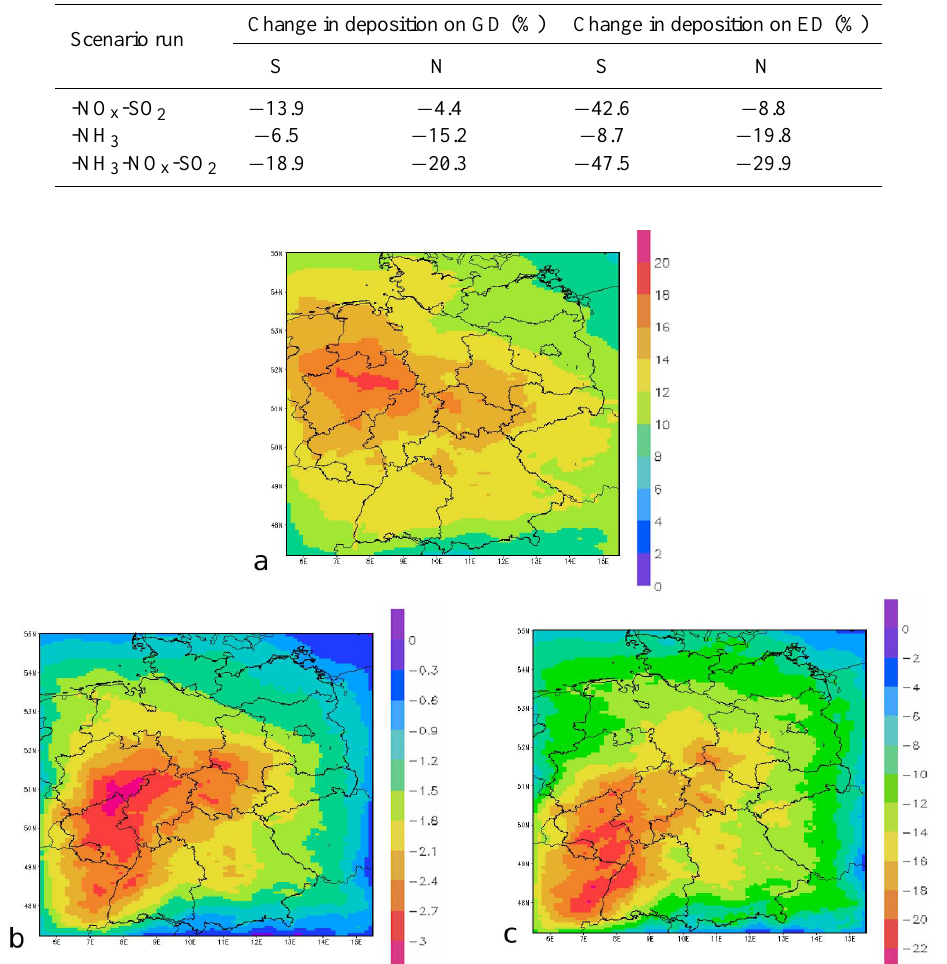
Table 6. Relative change in deposition of S and N compared to the base run for the German domain scenario runs and the European domain scenario runs.